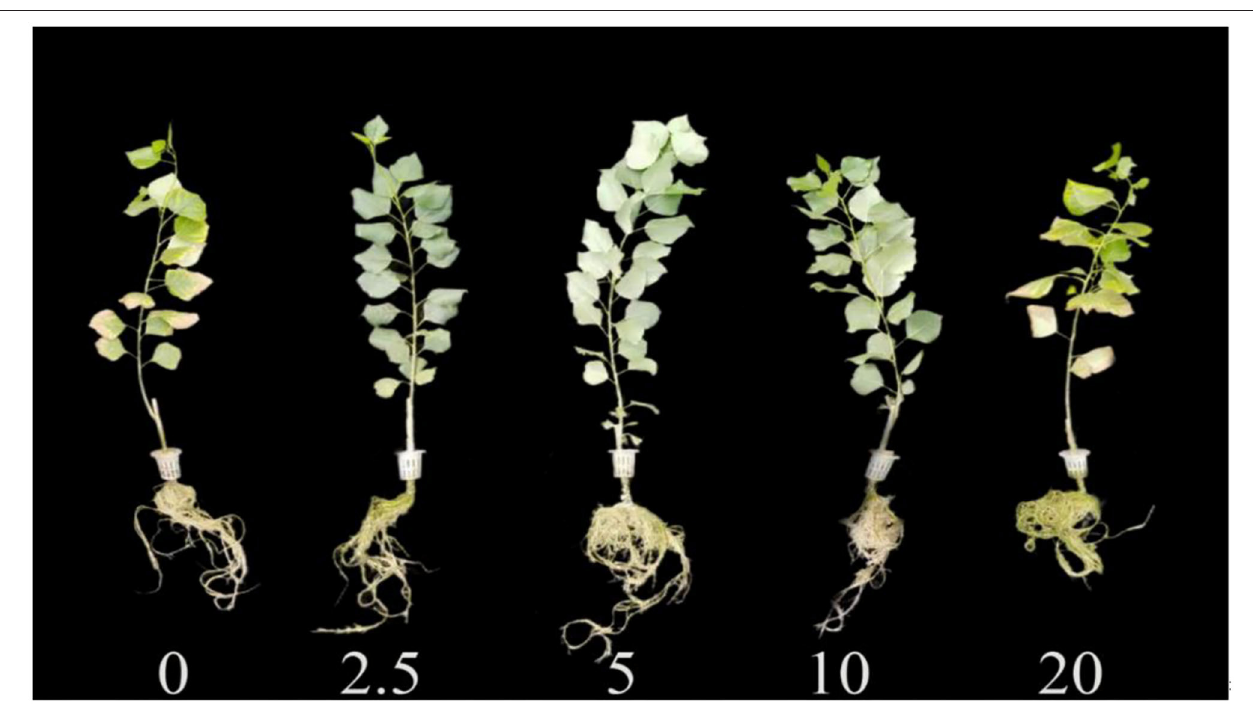
FIGURE 1 | Growth of poplar seedlings exposed to different calcium concentrations.